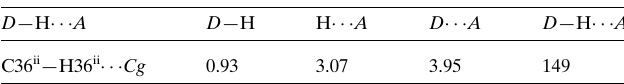
Table 1 Hydrogen-bond geometry (A˚ , (cid:6) ). Cg is the centroid of the C24–C26/C24 1 –C26 i